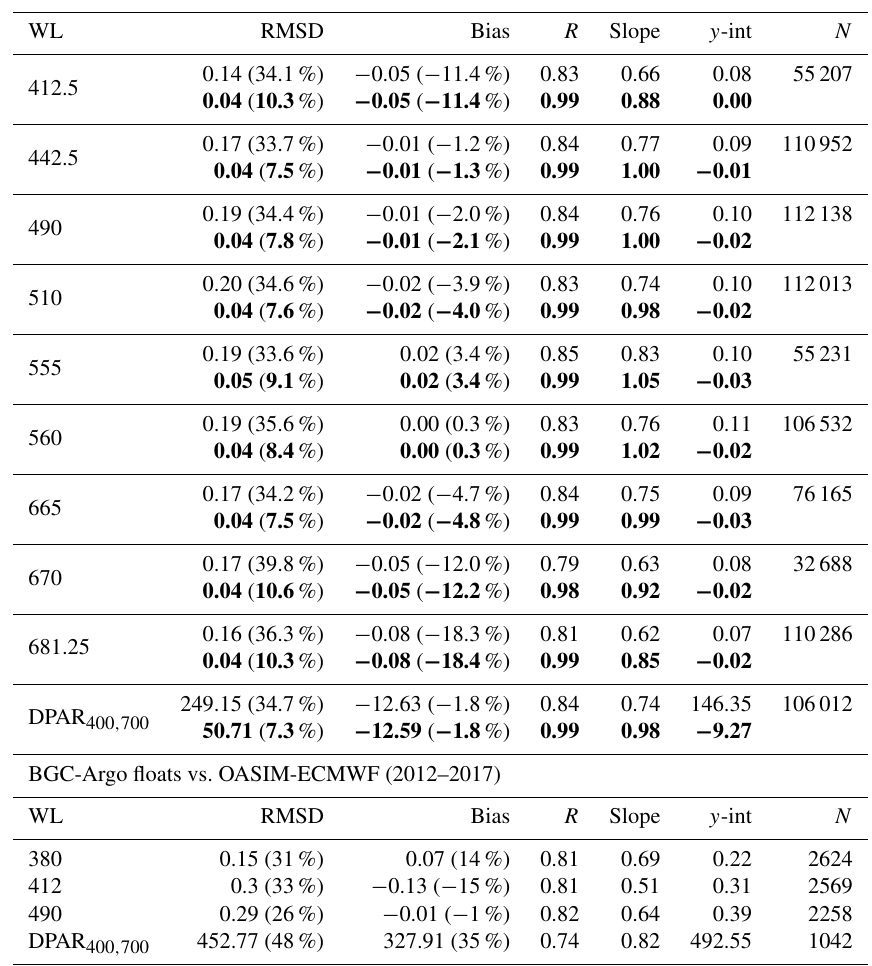
Table 1. Summary of the model skill compared to the available data from the BOUSSOLE buoy (from 2004 to 2012) and BGC-Argo floats (from 2012 to 2017) for the irradiance ( E d ) at the different wavelengths (WLs) and for DPAR. RMSD, bias and y -int are expressed in watts per square metre per nanometre, and in regard to DPAR, the same statistical indicators are expressed in µmolquantam − 2 s − 1 , while all the other indicators (regression r and slope) are dimensionless, where N is the number of match-ups between the model and observations. For the BOUSSOLE comparison, the numbers in bold font are derived by filtering out the day-to-day variability (i.e. the intra-monthly variability). Given the large number of samples, all statistics are significant ( p value < 0.05). For the RMSD and bias, the percentage values normalized by average data are reported in